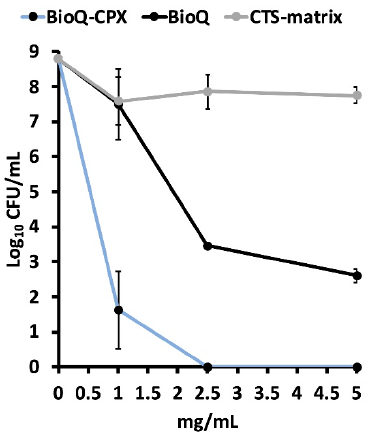
Figure 12. Antimicrobial activity of BioQ-CPX, BioQ, and CTS-matrix against S. aureus ATCC 25923 grown as planktonic cells as a function of applied concentrations ( n = 3 ± SD).